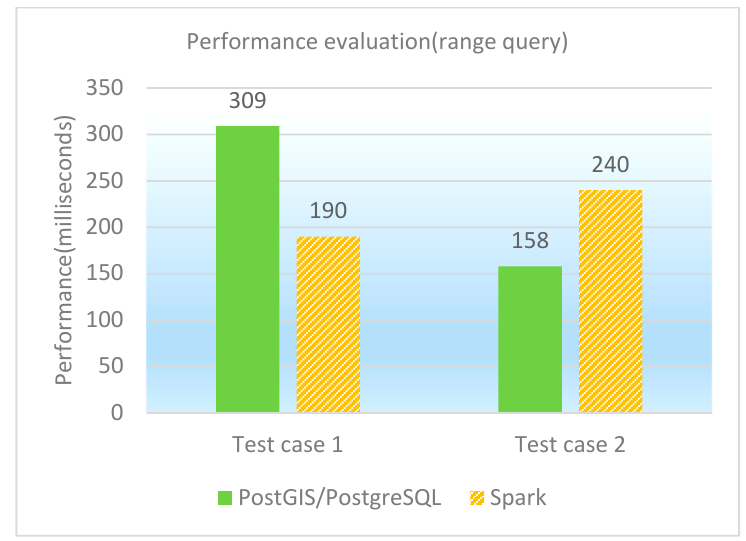
Figure 9. Performance comparison graph of range queries (in milliseconds).